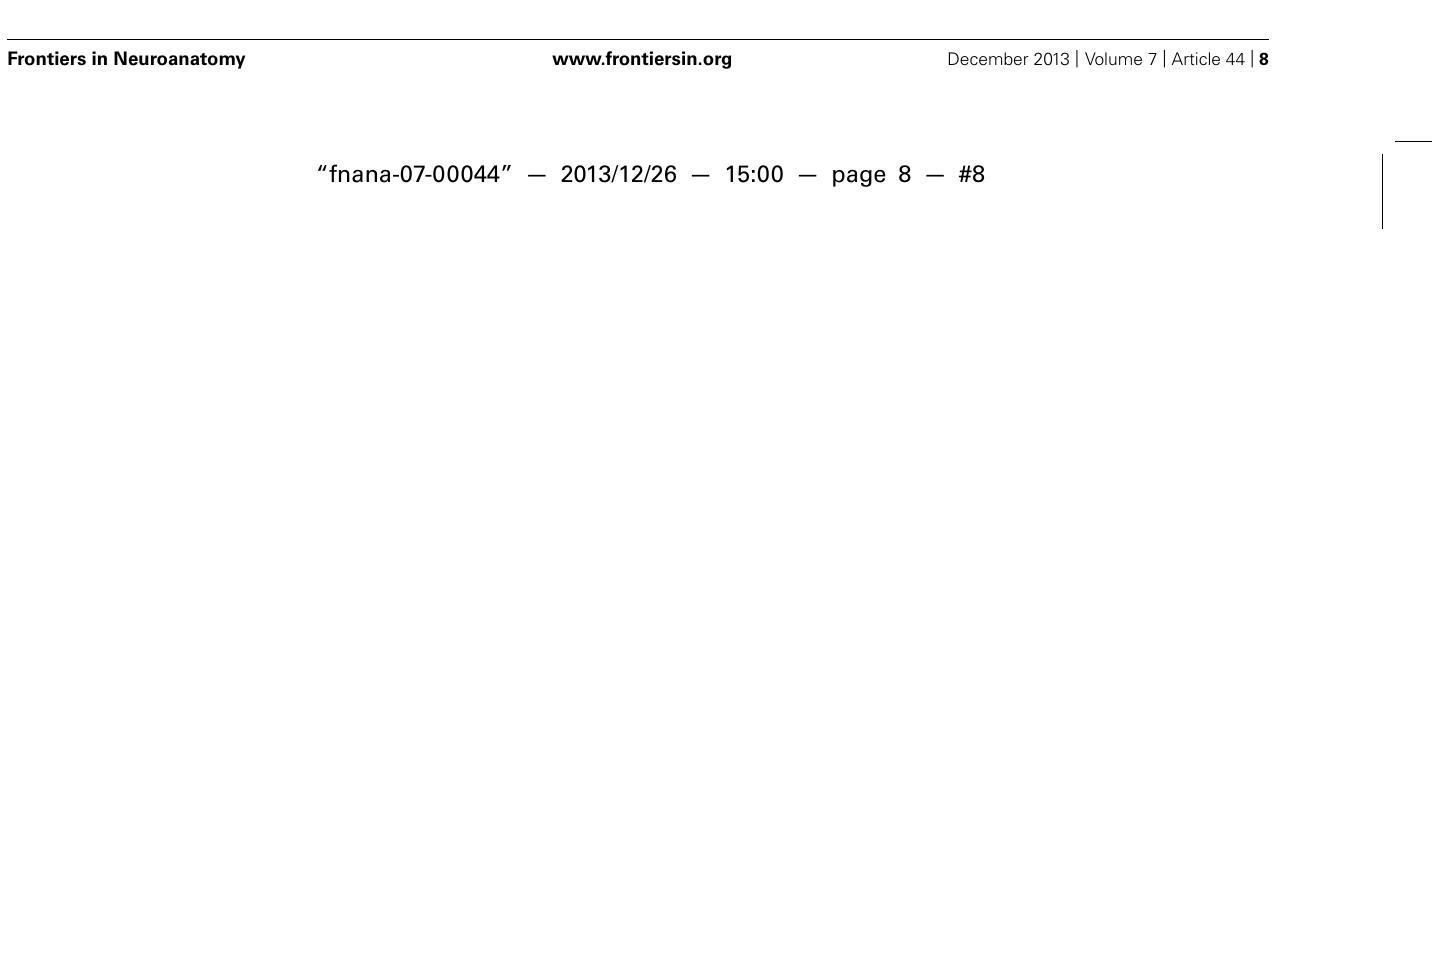
have lost dendrite and axons when compared with the normal neurons in (A,B) ], (E,F) CNTF-treated EAE rats, (G,H) C16-treated EAE rats, and (I,J) C16 + CNTF-treated rats. More axons were shown in these groups. (K,L) Treatment with CNTF or C16 prevented axon loss. a P < 0.05 versus the normal control; b P < 0.05 versus vehicle-treated EAE rats; c P < 0.05 versus CNTF-treated EAE rats; d P < 0.05 versus C16-treated EAE